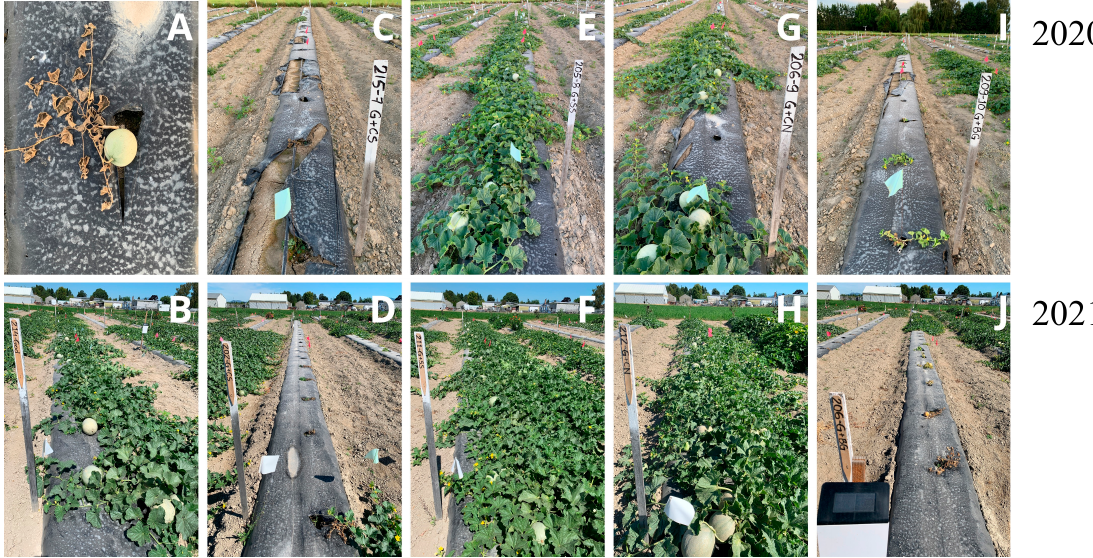
Figure 2. Plant growth of cantaloupe cultivar Goddess nongrafted ( A , B ), grafted with ‘Carolina Strongback’ ( C , D ), with ‘Super Shintosa’ ( E , F ), with ‘Carnivor’ ( G , H ), and with ‘Pelop’ ( I , J ) rootstocks at 10 WAT in 2020 and 2021, respectively, at Mount Vernon, WA, USA.